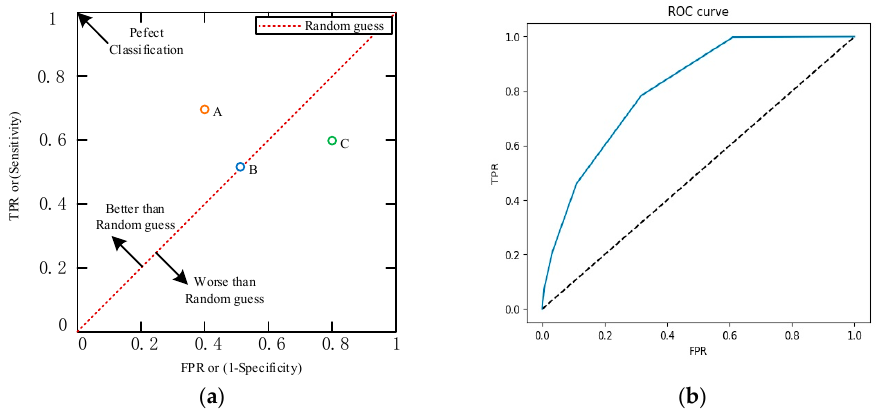
Figure 7. The confusion matrix.